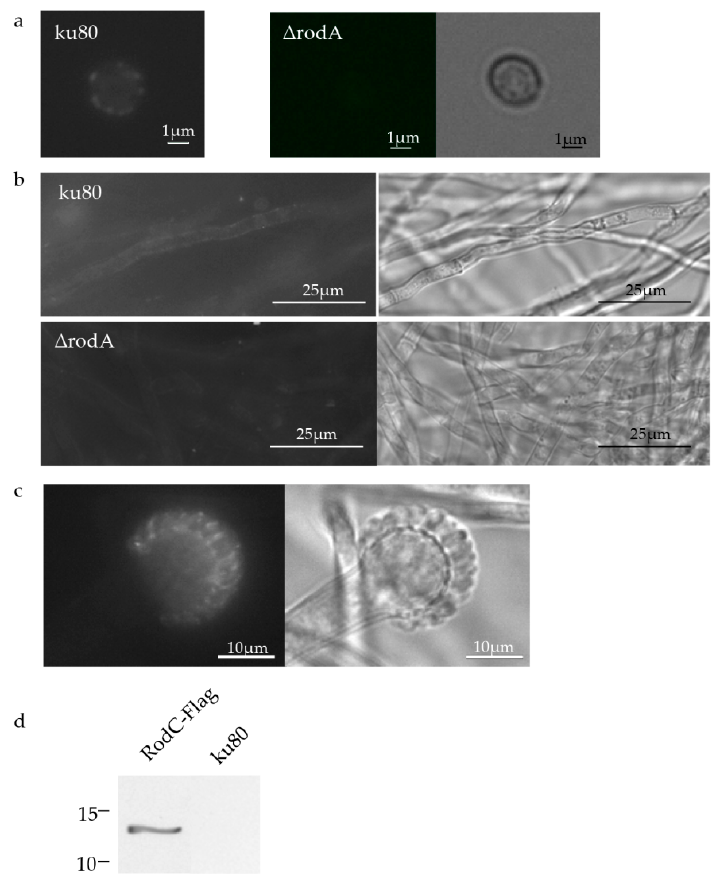
Figure 3. Localization of RodA and RodC. Immunofluorescence localization of RodA on conidia ( a ) and biofilm ( b ) cell walls, and on phialides ( c ) of ku80 ( ∆ rodA was used as a negative control) using the anti-recombinant RodA polyclonal antiserum. Immunoblotting localization of formic acid-soluble material of RodC-Flag and ku80 (negative control) conidia using an anti-Flag monoclonal antibody ( d ).